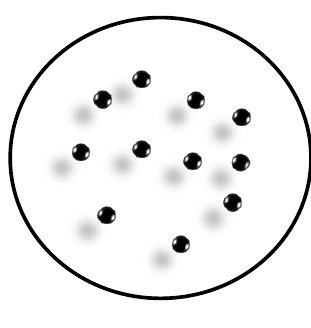
Figure 1 . The black solid circles are the inclusion regions, V M ( L ), where matter is present. Within these regions entropy is removed, and the displacement satis(cid:12)es O i u i = (cid:0) V (cid:3) regions entropy is not removed, and the displacement satis(cid:12)es O i u i =